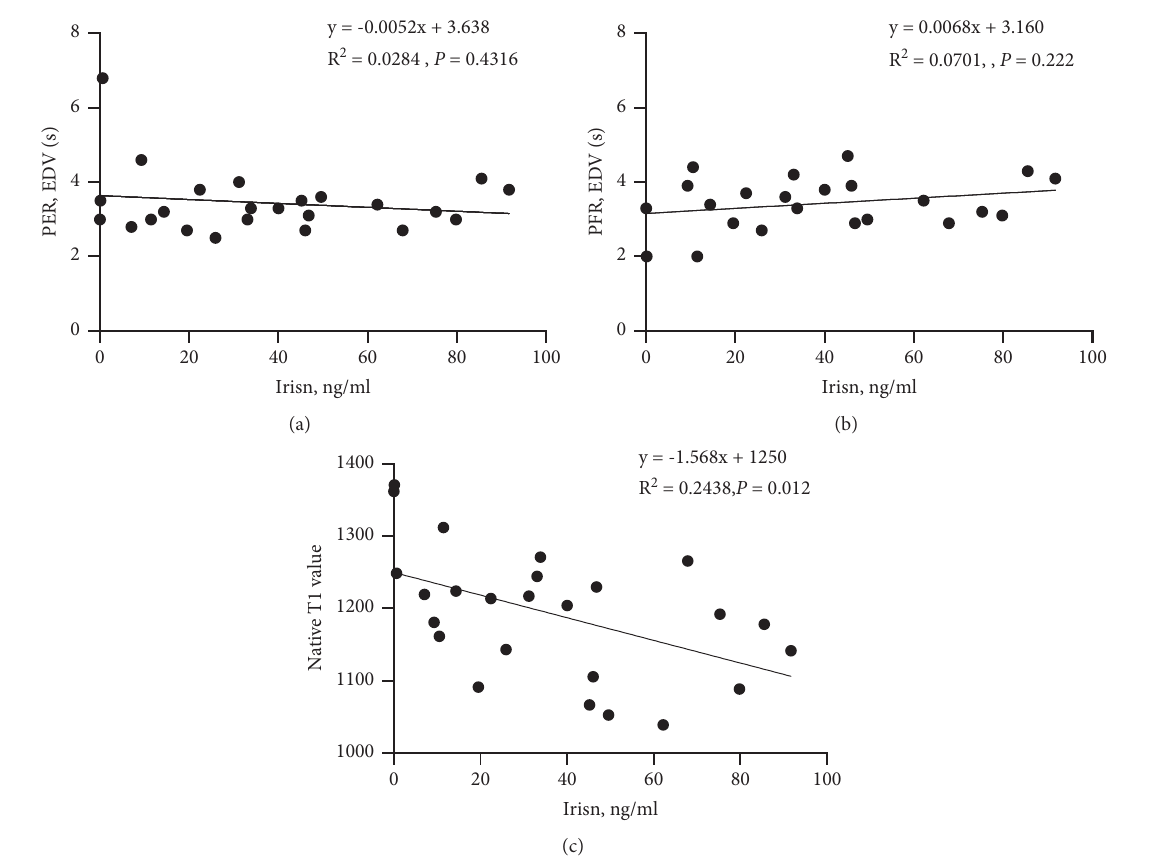
Figure 3: Correlation between serum irisin levels and PER (a), PFR (b), and native T1 values (c) in patients with severe